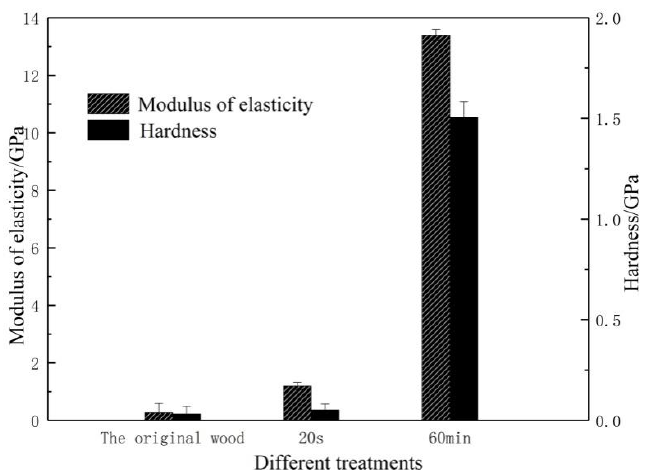
Figure 5. Hardness and elastic modulus of metallized wood.